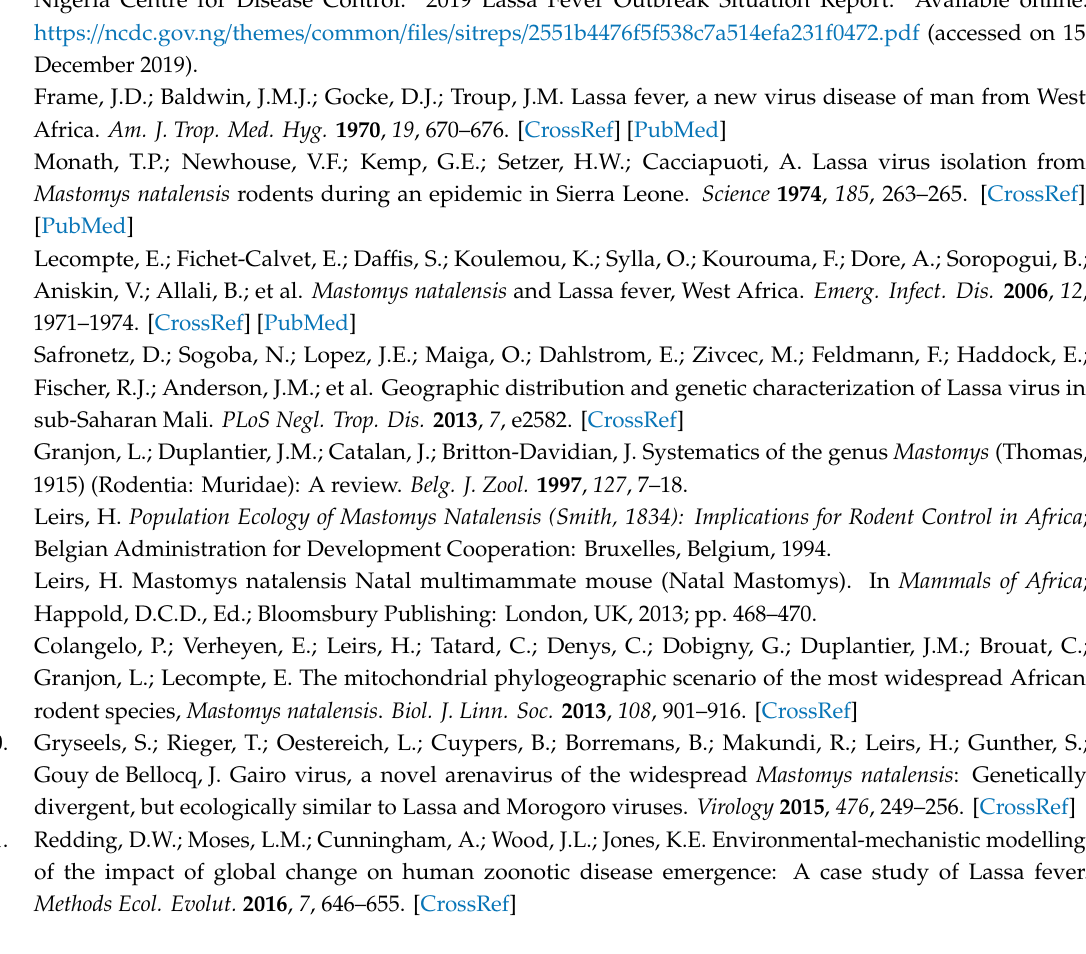
Figure S1: Photos of rodent reservoirs of Lassa